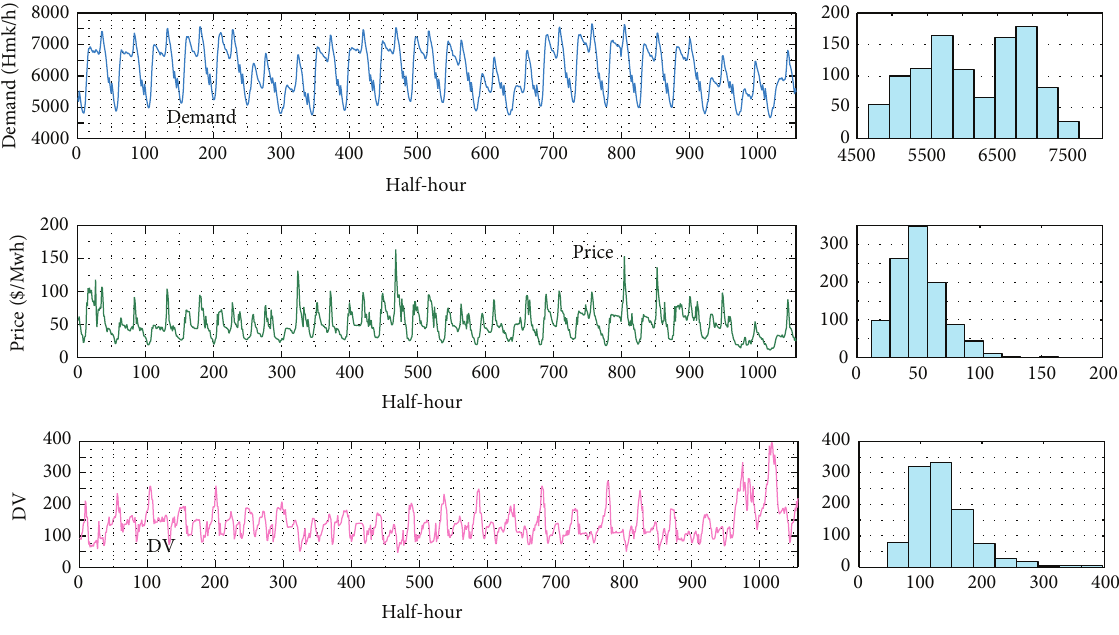
Figure 6: Schematic diagram of the electricity price demand and DV.